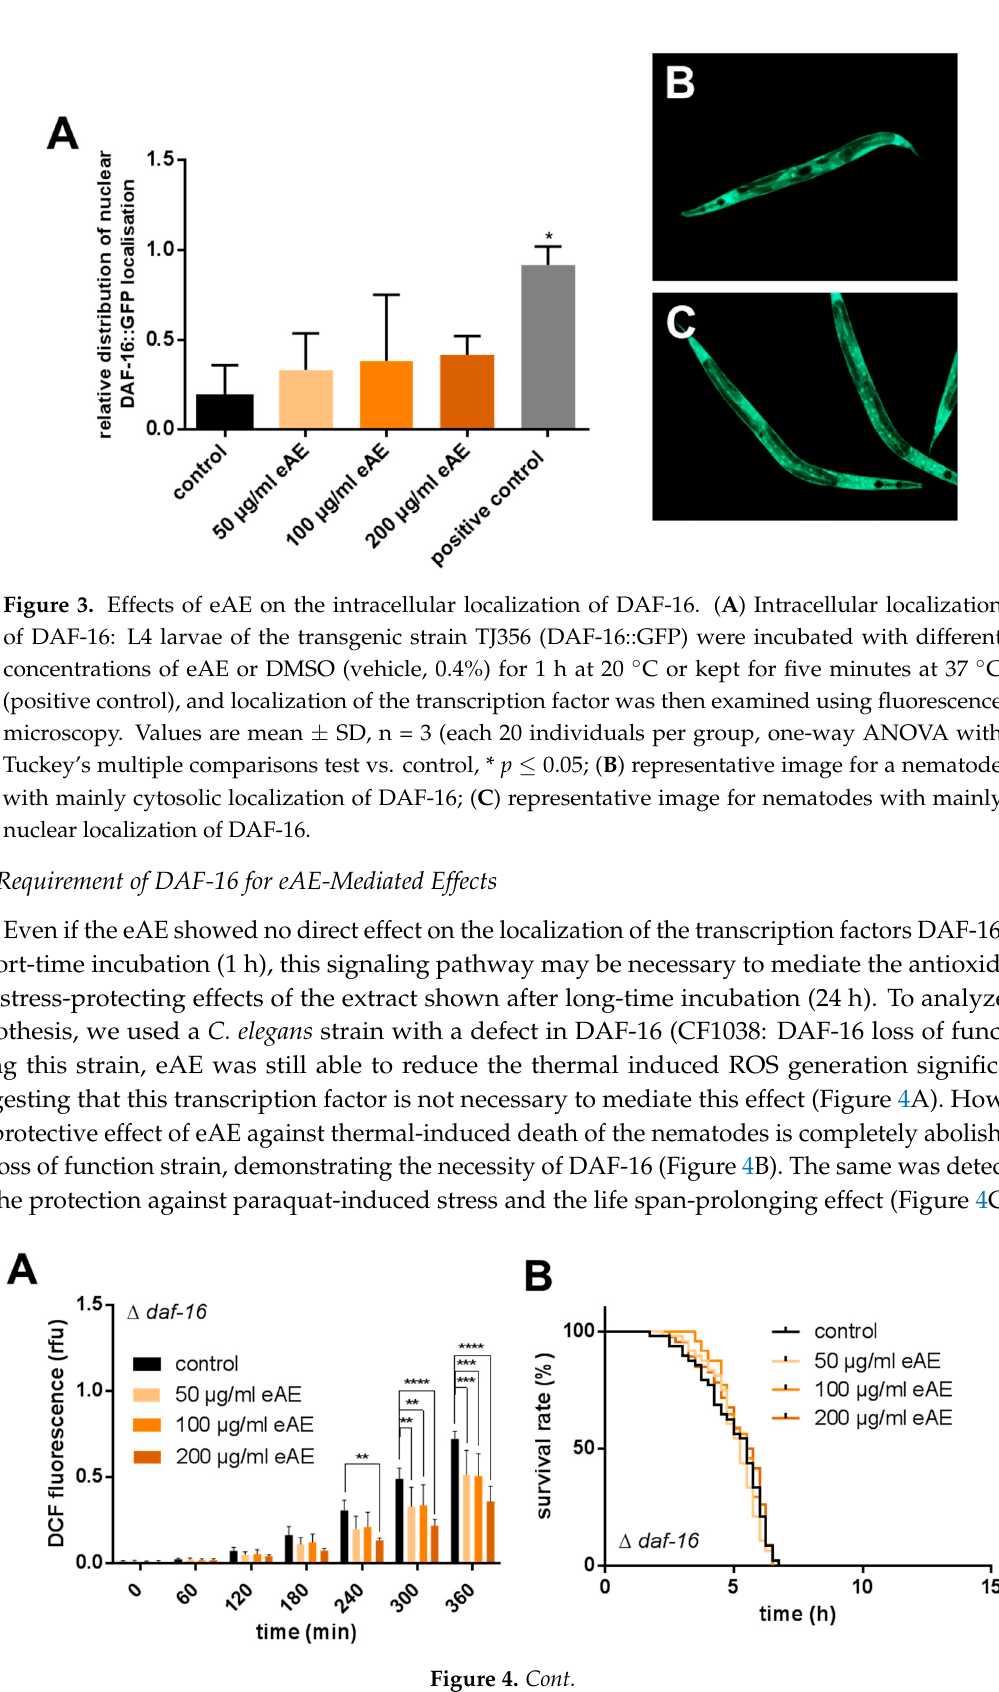
Figure 4. Requirement of DAF-16 for the protective effects of eAE. ( A ) Thermally induced increase in ROS (DCF assay): L4 larvae deficient in DAF-16 were treated with different concentrations of eAE or with DMSO (vehicle, 0.4%) for 24 h at 20 °C. After washing, they were transferred individually into the wells of a 384-well plate containing 50 µM H 2 DCF-DA. The increase in fluorescence was measured at 37 °C. Values are mean ± SD, n = 3 (each 16 individuals per group), two-way ANOVA with Dunnett’s multiple comparisons test vs. control at the correspondent time point, ** p ≤ 0.01, *** p ≤ 0.001, **** p ≤ 0.0001; ( B ) Thermal stress resistance: L4 larvae deficient in DAF-16 were treated with different concentrations of eAE or with DMSO (vehicle, 0.4%) for 24 h at 20 °C. After washing, they were transferred individually into the wells of a 384-well plate containing 1 µM SYTOX ® Green. The increase in fluorescence was measured at 37 °C. The graph shows the percentage of viable nematodes. Kaplan-Meier statistics were used for the comparison of the survival curves, n = 3 (each 16 individuals per group), Log Rank (Mantel-Cox) test; ( C ) Oxidative stress resistance: L4 larvae deficient in DAF- 16 were incubated with eAE or with DMSO (vehicle, 0.4%) for 72 h at 20 °C. Then, all nematodes were transferred into extract-fee media containing 50 mM paraquat. Every 24 h, the survival of the nematodes was surveyed via touch-provoked movement. Kaplan-Meier statistics were used for the comparison of the survival curves, n = 3 (each 40 individuals per group), Log Rank (Mantel-Cox) test; ( D ) Modulation of life span: L4 larvae deficient in DAF-16 were incubated with different concentrations of eAE or DMSO (vehicle, 0.4%). On five days a week, media were exchanged and survival of the nematodes was tested via touch-provoked movement. Kaplan-Meier statistics were used for the comparison of the survival curves, n = 3 (each 40 individuals per group), Log Rank (Mantel-Cox) test, * p ≤ 0.05, ** p ≤ 0.01. Calculated data for thermal and oxidative stress resistance, as well as lifespan, are shown in Supplementary Tables S1–S3. 4. Discussion It is well-known that extracts from Agrimonia spp. possess a high radical scavenging capacity, which is measured via the reduction of colored radicals (ABTS: 2,2-azinobis (3-ethylbenzothiazoline- 6-sulfonic acid); DPPH: 2,2-Diphenyl-1-picrylhydrazyl) in vitro [3,9] . It is also known that extracts from Agrimonia spp. are able to protect against oxidative stress in vivo [9]. The aim of our study was to investigate the antioxidative effects of an agrimony extract in greater detail to show, e.g., dose- dependent effects in vivo , as well as molecular mechanisms of the effects using the model organism Caenorhabditis elegans . Antioxidative effects of plant compounds/plant extracts in vivo may be directly